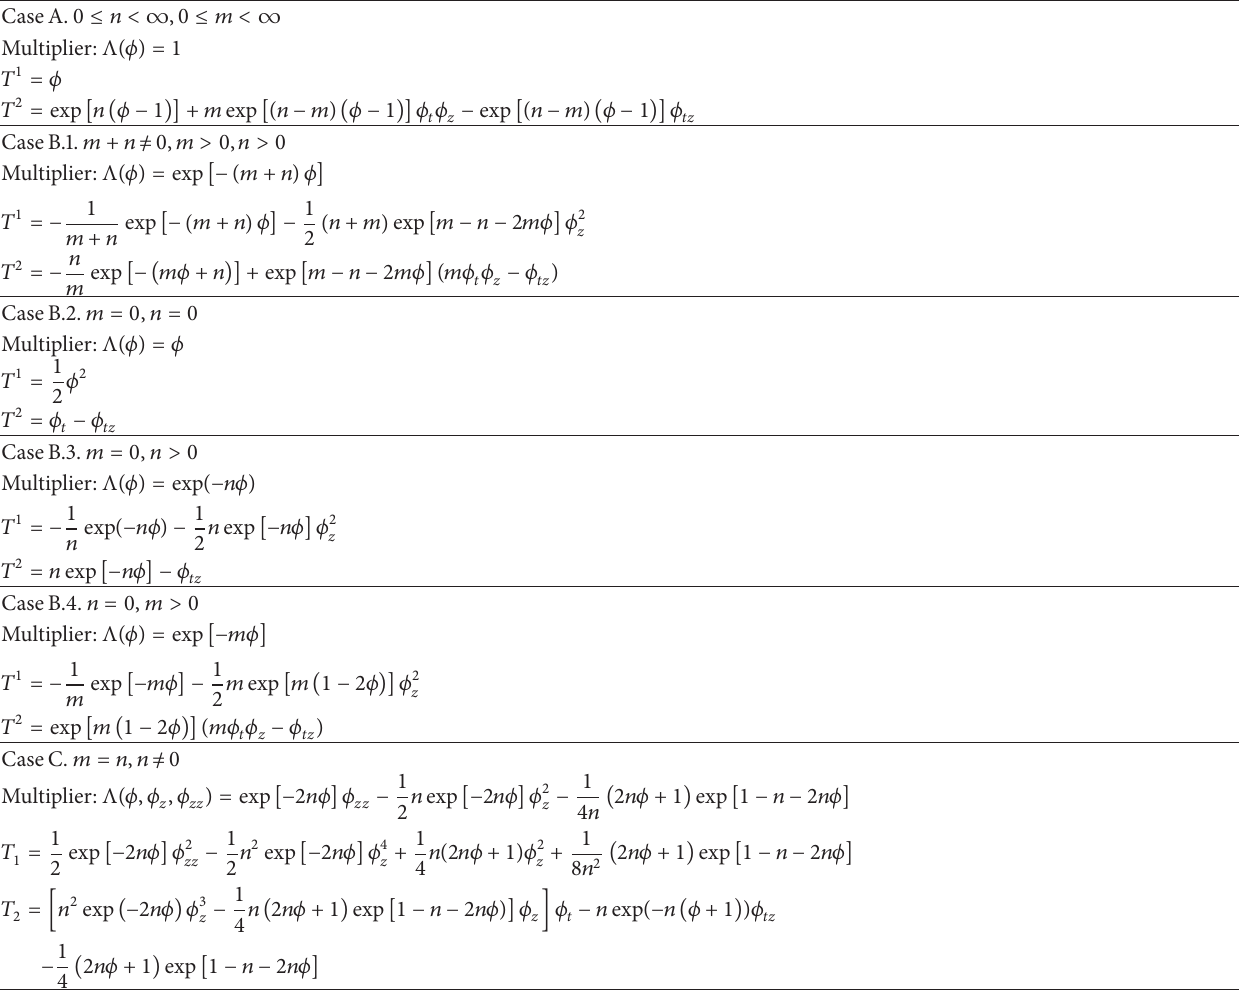
Table 3: Multipliers and conserved vectors for the partial differential equation